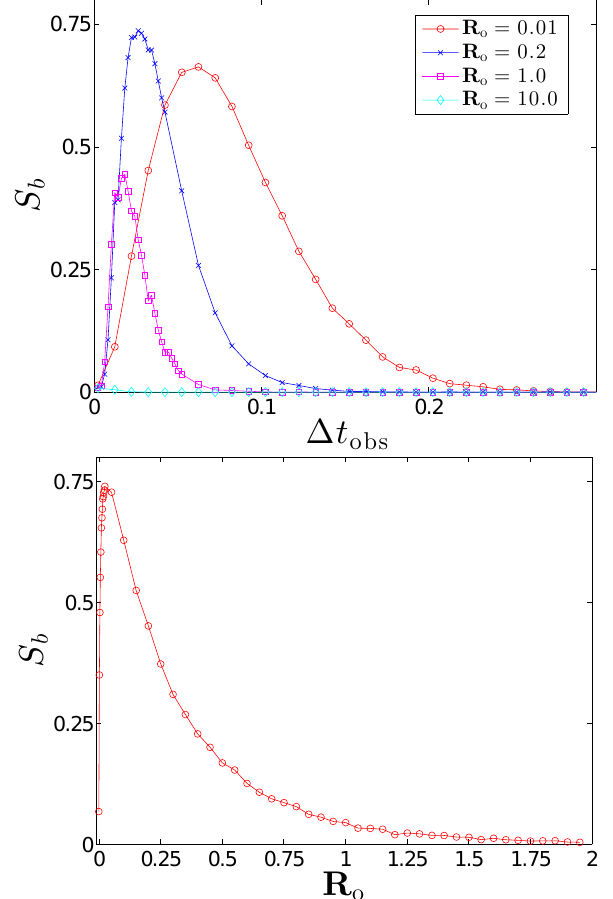
Fig. 4. Top: percentage S b of blow-ups as a function of the obser- vation interval 1t obs for several values of the observational noise R o for fixed number of analyses cycles n a = 4000, integration time step d t = 0 . 0025. Bottom: percentage S b of blow-ups as a function of the observational noise variance R o for fixed number of analyses cycles n a = 4000, integration time step d t = 0 . 0025 and observa- tional interval 1t obs = 0 . 05.